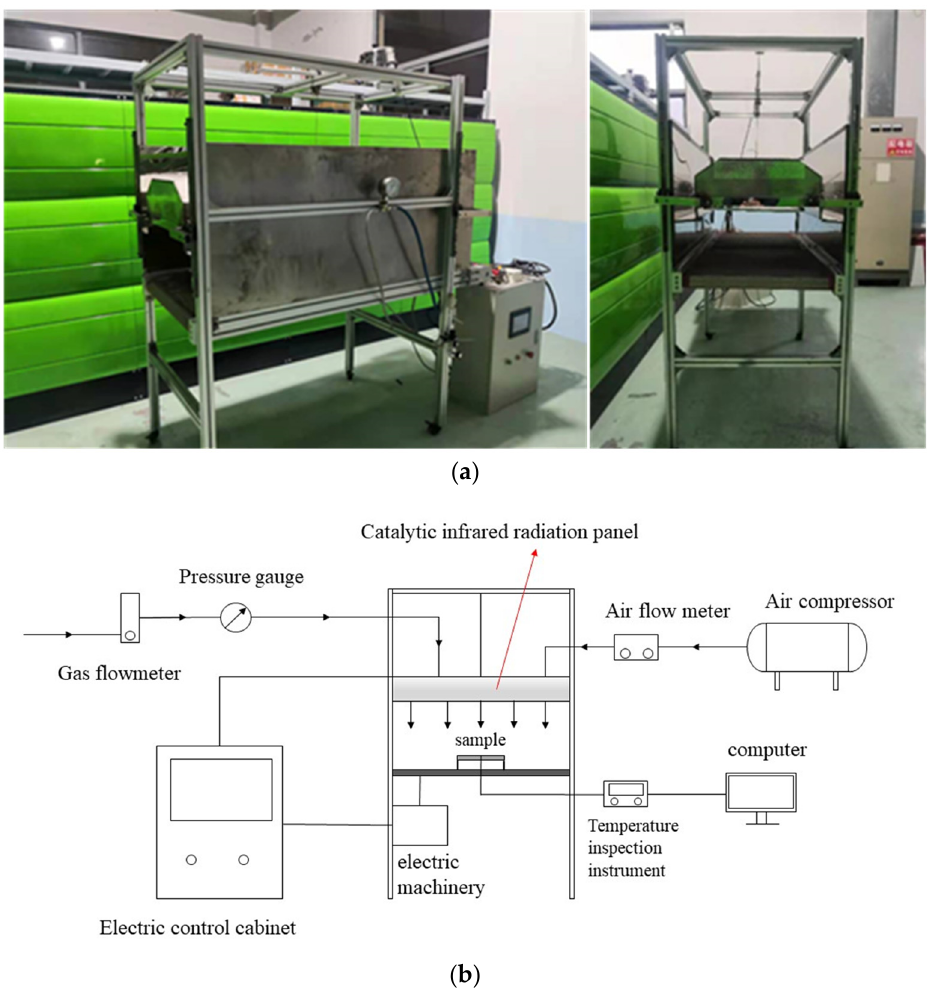
Figure 2. ( a ) Catalytic infrared curing oven. ( b ) Schematic diagram of infrared curing furnace with catalytic combustion. catalytic combustion.